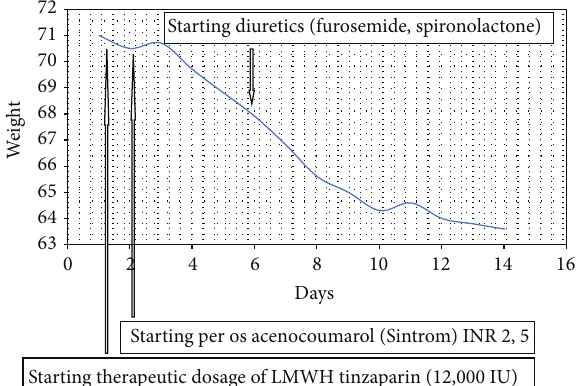
Figure 5: Weight decrease resembling ascites